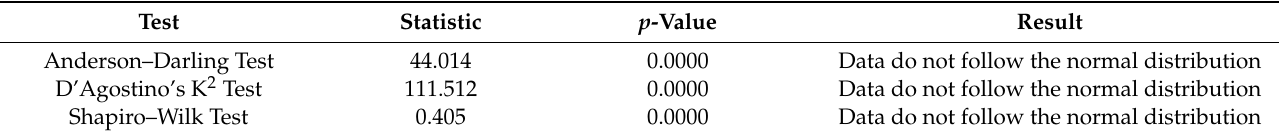
Table 6. Normality